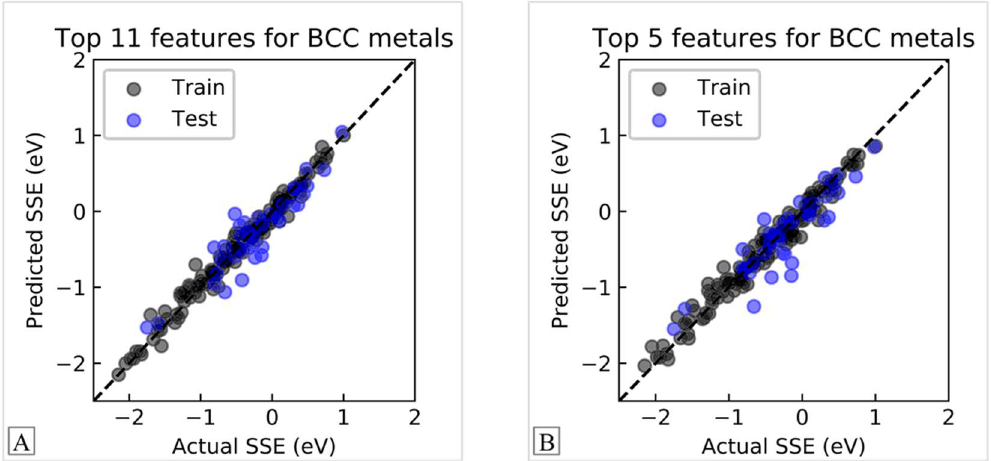
Figure 5. GBR model predictions for BCC(110) surfaces using ( A ) 11 features and ( B ) 5 features. SSE = surface segregation energy.